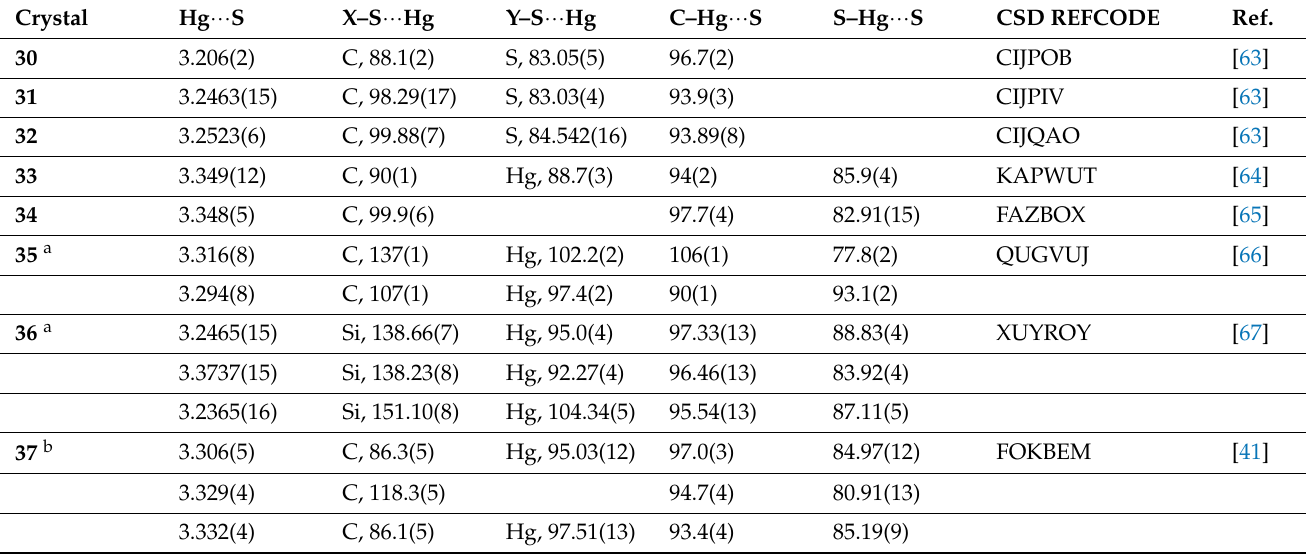
Table 3. Summary of geometric parameters (Å, ◦ ) for 30 – 37 , each featuring Hg ··· S contacts within zero-dimensional